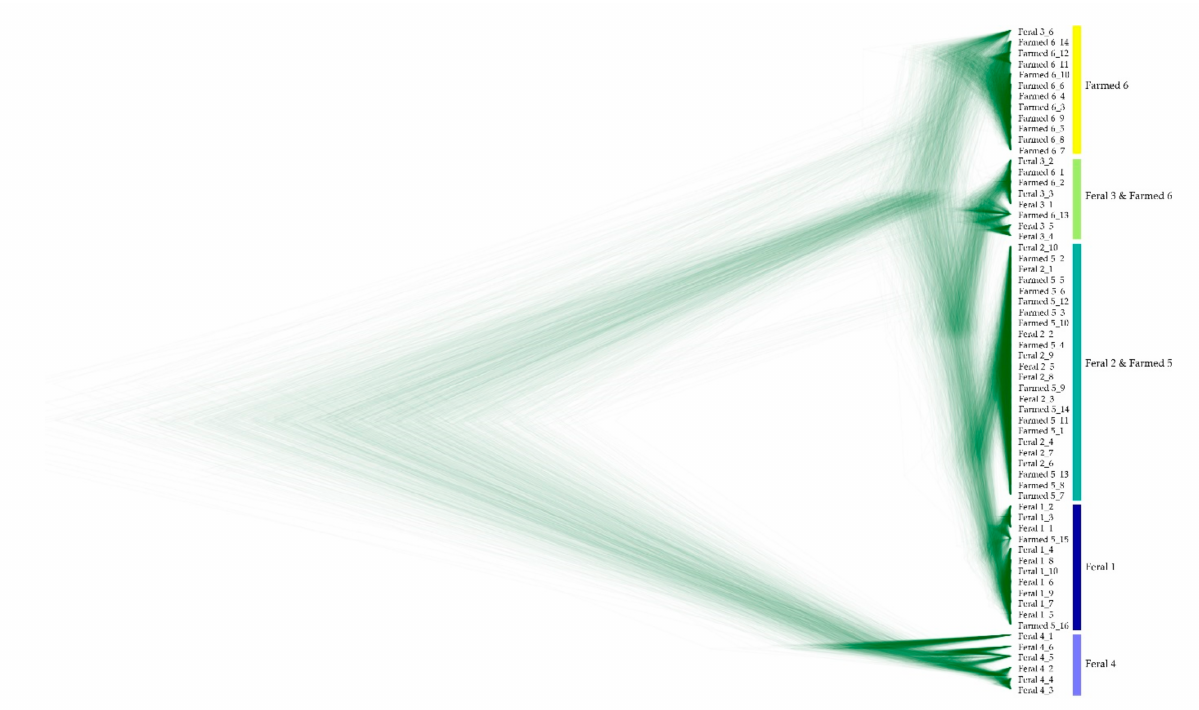
Figure 3. The phylogenetic relationships among Cyt-b haplotypes for feral and farmed mink display the whole trees generated from